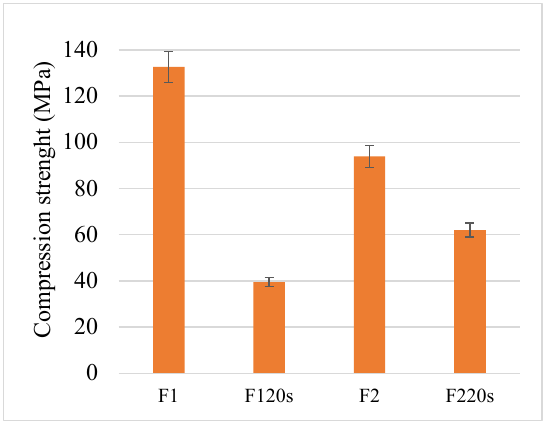
Figure 9. The compression strength of all forsterite samples.